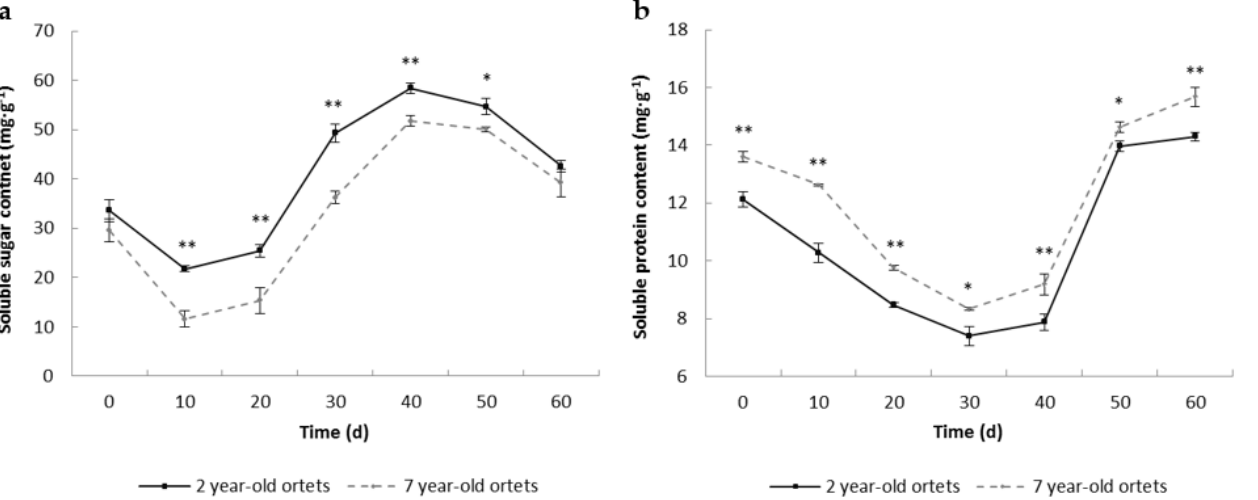
Figure 4. Organic nutrients of cuttings from 2- and 7-year-old ortets during cultivation. ( a ) Soluble sugar; ( b ) Soluble protein. Each data point contains three replicates, and error bar means standard deviation. * and ** indicate significantly differences under 0.05 and 0.01 level, respectively. The same below.